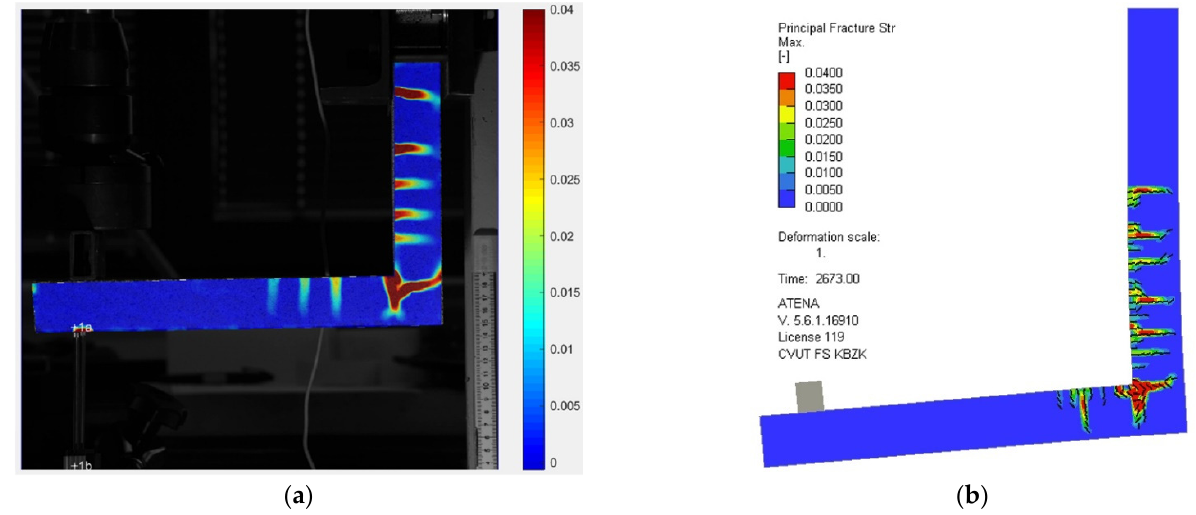
Figure 15. Comparison of the crack development and opening during the opening of the rigid frame. Principal strain of the experimental setup as captured by the DIC ( a ) and image depicting numerical strain predicted by the numerical analysis ( b ).